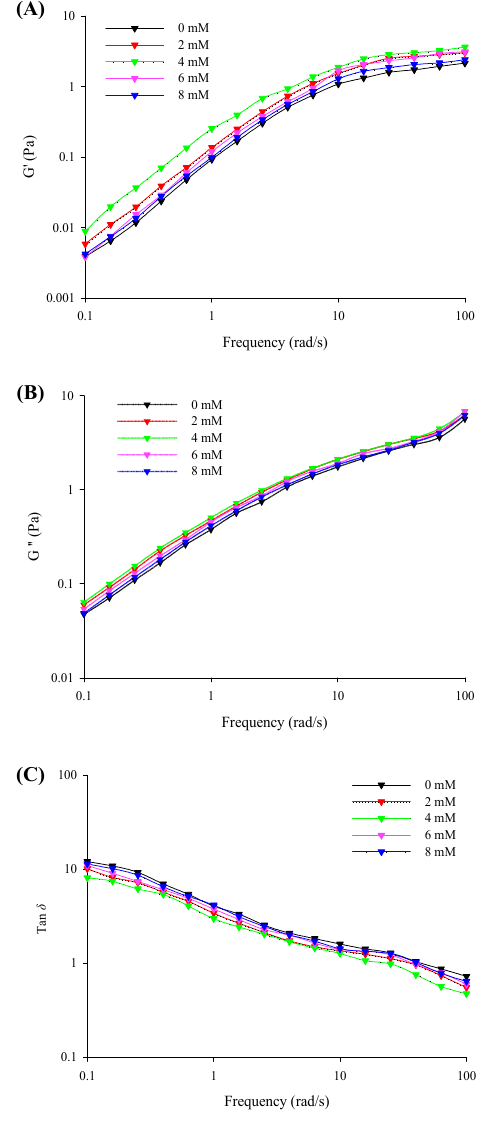
Figure 3. Storage moduli ( G ′ , A ), loss moduli ( G ″ , B ), and phase angle (tan δ , G ″ / G ′ , C ) of the freshly prepared filled hydrogels containing different CaCl 2 levels as a function of frequency.